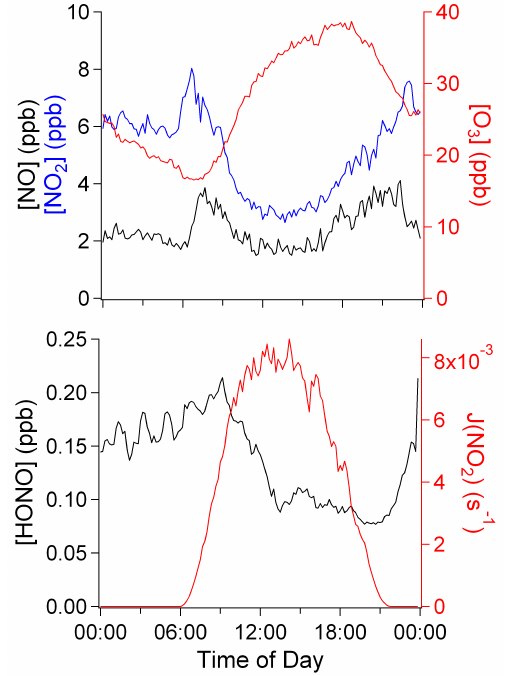
Fig. 2. Average diurnal 10min profiles for O 3 , NO x , HONO, and J (NO 2 ) during the MEGAPOLI summer campaign (local time).